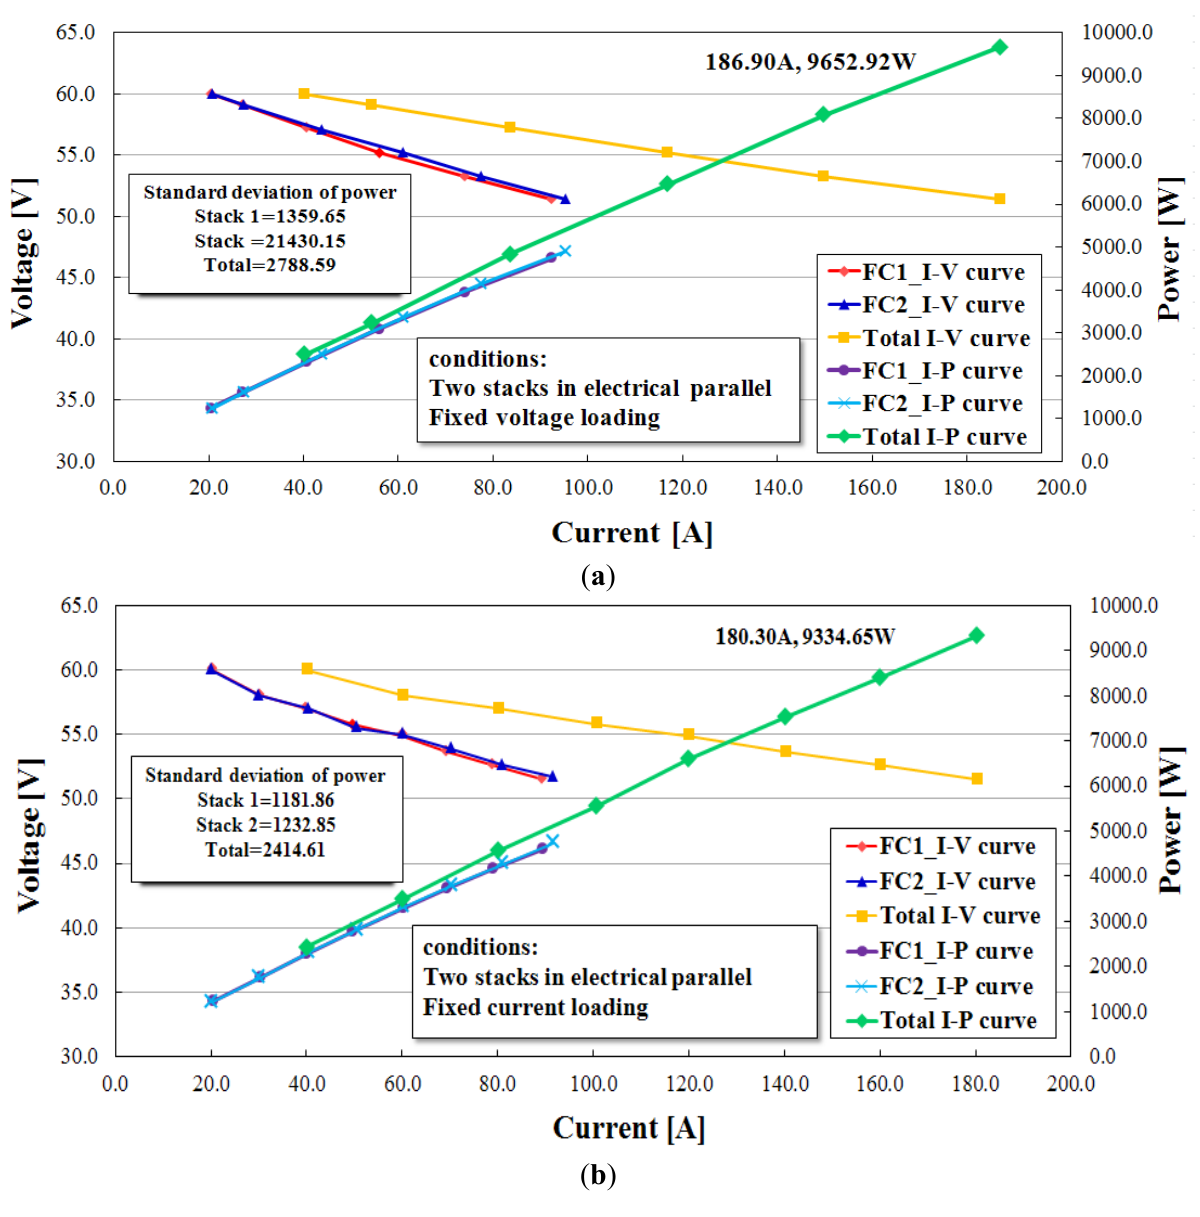
Figure 5. The I - V and I - P curves of each stack in electrical parallel: ( a ) fixed voltage loading; and ( b ) fixed current